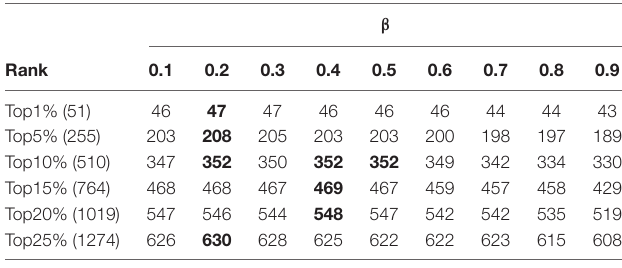
The bold values represent the best predictive performance achieved by LNSPF under different